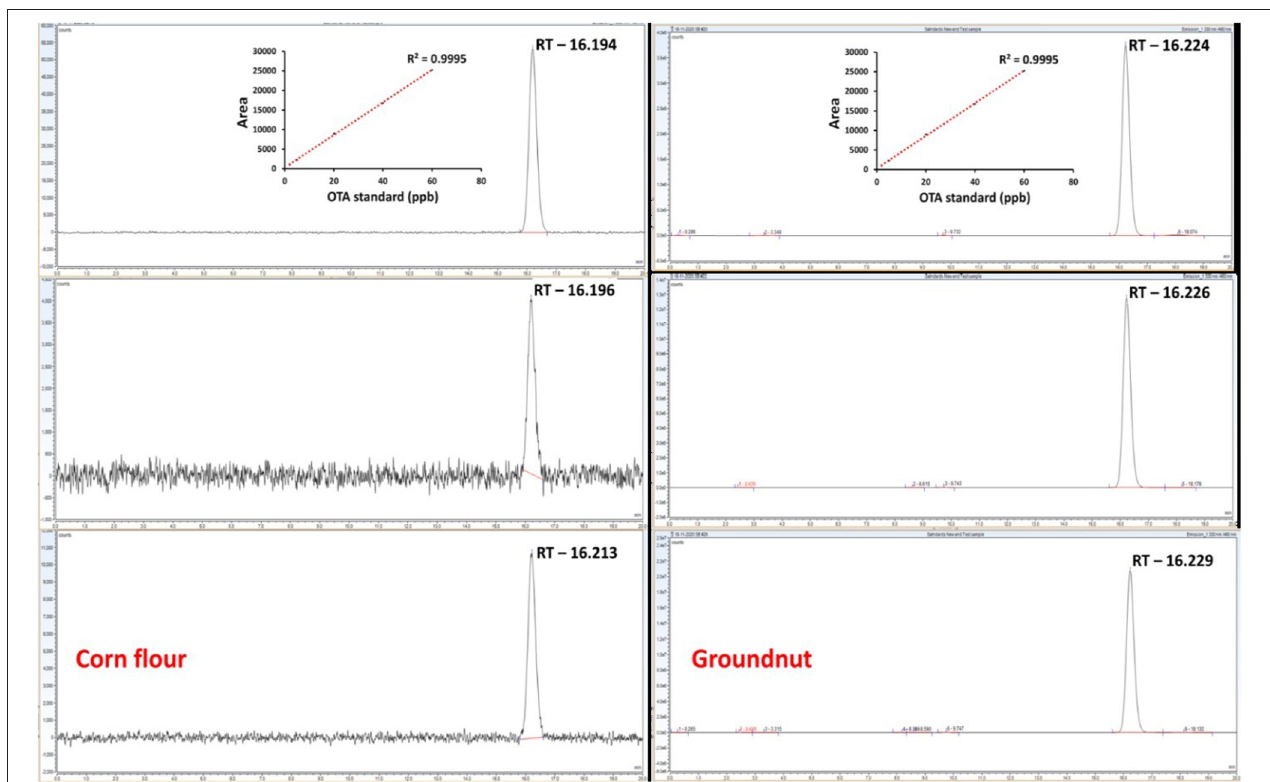
FIGURE 6 | Comparison of the proposed aptamer and salt-induced AuNPs-based colorimetric OTA sensor with conventional HPLC-based detection in spiked corn and groundnut